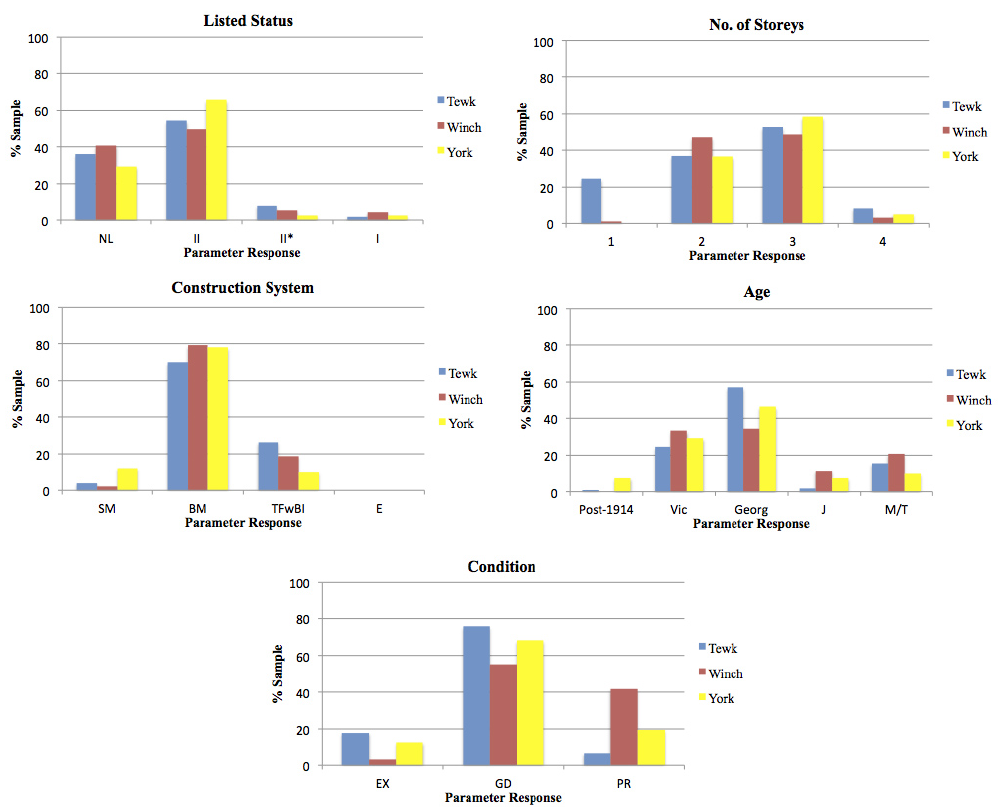
Fig. 4. Distribution of vulnerability parameter responses for three sites: Tewkesbury, Winchester and York.